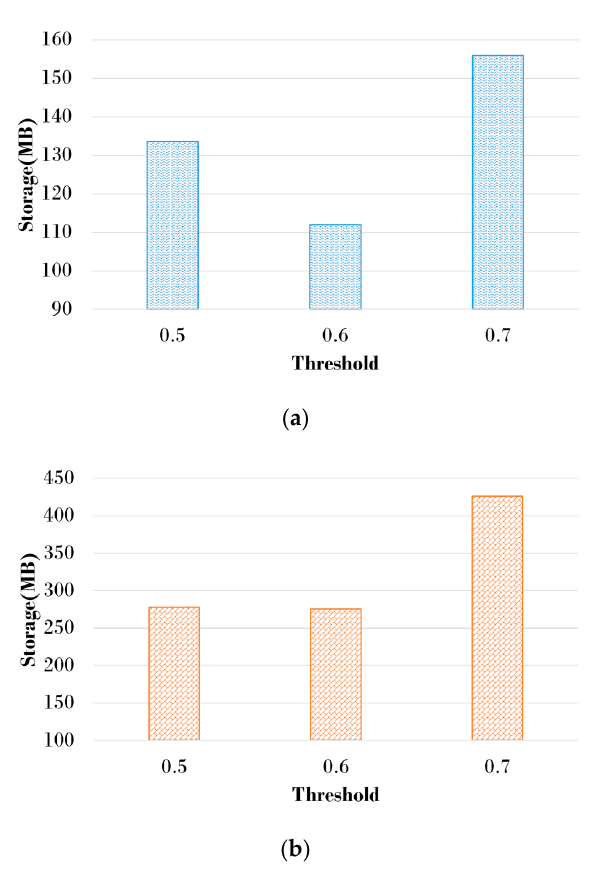
Figure 10. Storage usage according to the threshold: ( a ) Dataset1; ( b ) Dataset2.